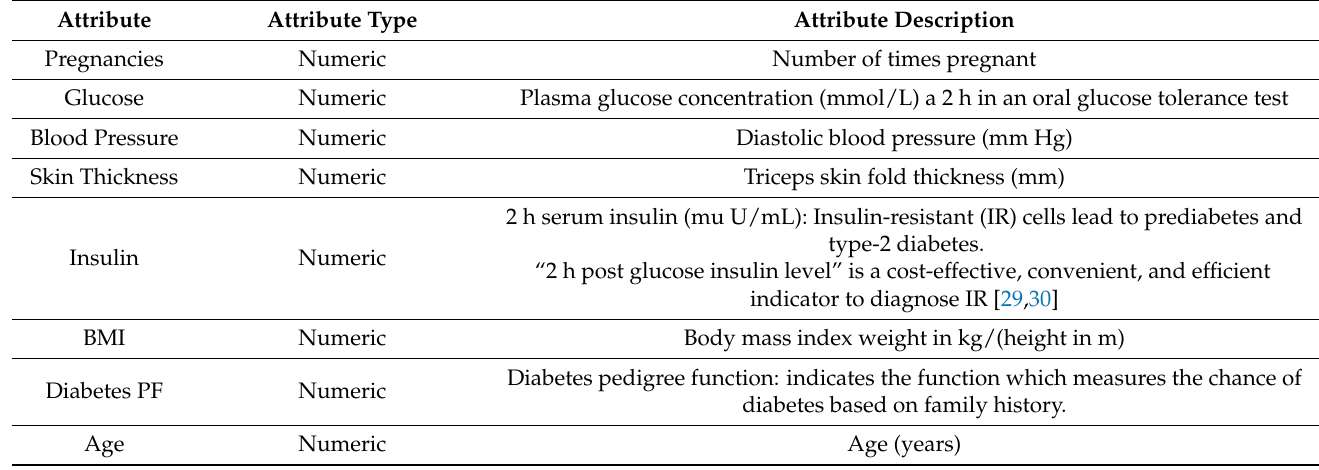
Table 2. Statistical description of the Pima Indian Diabetes